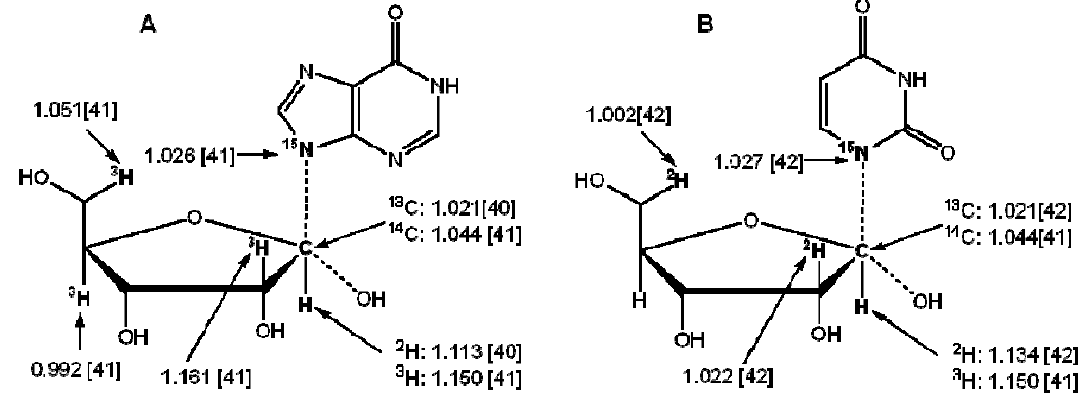
Figure 1. Observed KIEs of inosine ( A ) and uridine ( B ) for the enzymatic catalysis determined with GC-MS, LC-MS and radioactive-labeled methods [40–42].